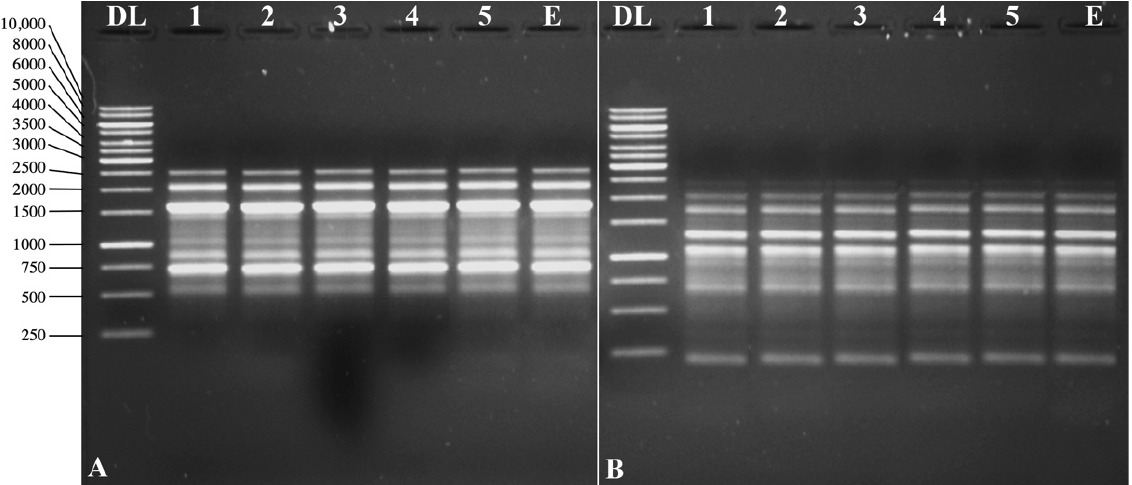
Figure 3. Showing genetic stability between randomly selected in vitro plants and donor plants using RAPD markers in L. speciosa. ( A ) Amplified profile from primer OPB-01; ( B ) amplified profile from primer OPB10. DL—DNA ladder; lanes 1–5: randomly selected in vitro plants; lane E: donor plant.